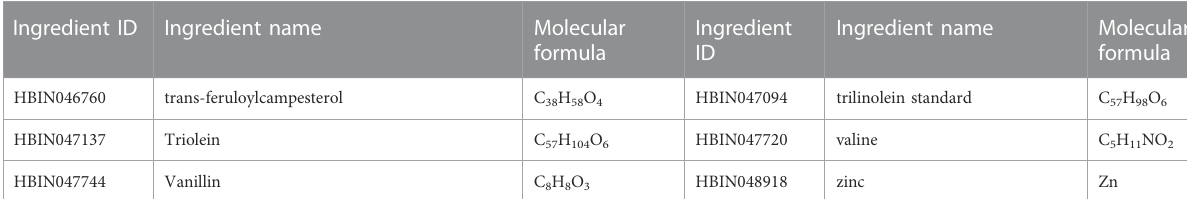
TABLE 2 ( Continued ) Constituent ingredients of Coicis Semen , compiled from the HERB database (http://herb.ac.cn).